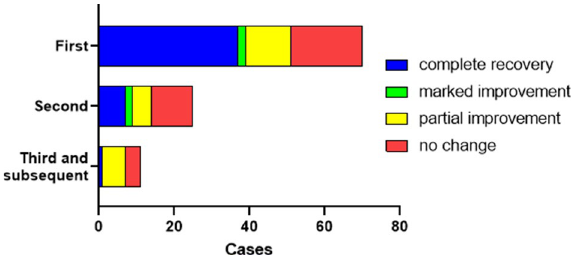
Figure 1. Hearing outcomes for successive episodes of sudden sensorineural hearing loss. The recovery rate decreased significantly as the number of hearing loss episodes increased, as evaluated by the Cochran-Armitage trend test ( P = 0.0011). A hearing outcome was designated as “no change” when the average hearing threshold improved by < 10 dB. This bar chart was created using GraphPad Prism 9.0.0 for Windows, GraphPad Software, San Diego, California USA, www. graph pad. com.